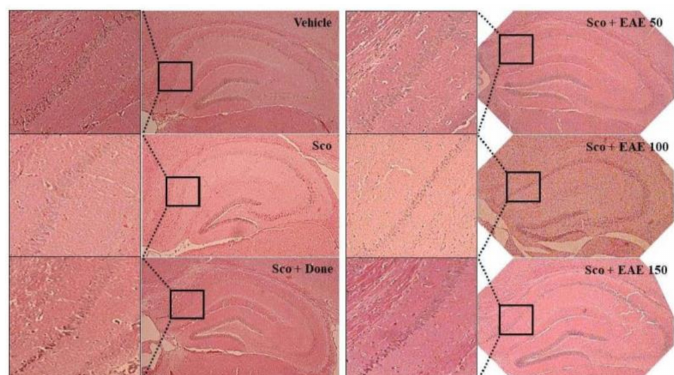
Figure 7. Prevention of scopolamine-induced neuronal damage in the hippocampal CA1 region by oral supplementation of EAE. The Vehicle, no treatment; Sco, i.p injection with scopolamine (5 mg / kg bw) alone, Sco + Don, treatment with donepezil followed by i.p. injection with scopolamine; Sco + EAE 50, treatment with EAE (50 mg / kg bw) followed by i.p. injection with scopolamine, Sco + EAE 100, treatment with EAE (100 mg / kg bw) followed by i.p. injection with scopolamine, Sco + EAE 150, treatment with EAE (150 mg / kg bw) followed by i.p. injection with scopolamine. A representative picture for each experimental group is depicted (magnification: 100 × or 400 ×